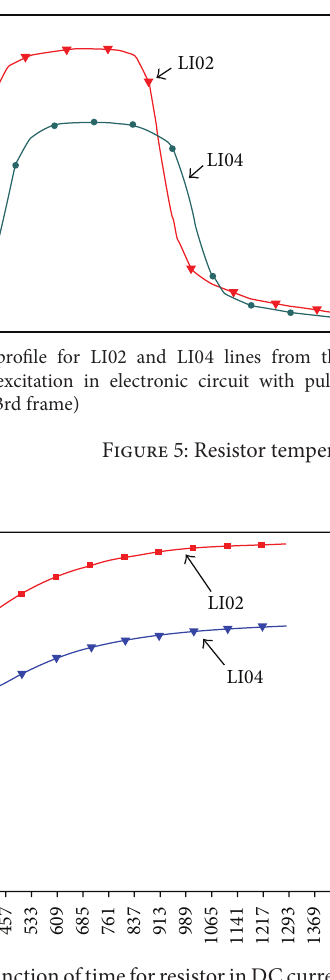
Figure6: Temperatureinfunction oftimeforresistorinDCcurrent circuit (INS0234.SEQ, from 1st to 1000th